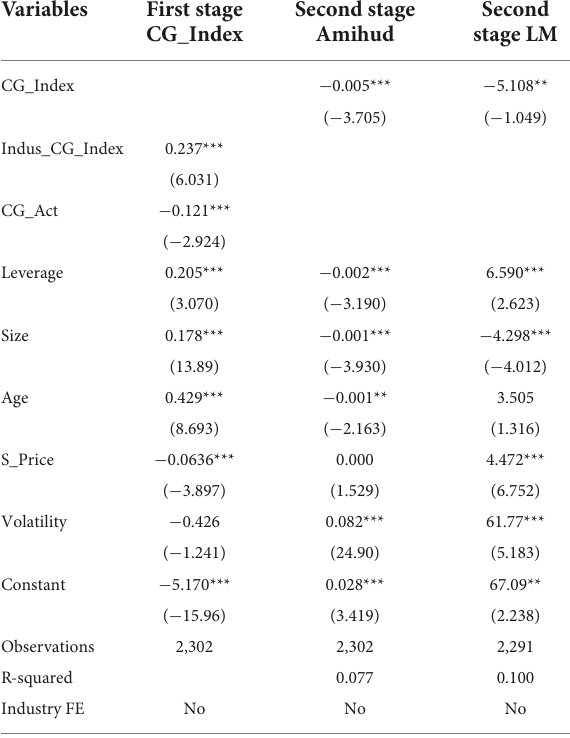
TABLE 7 Corporate governance, Institutional Quality, and stock liquidity